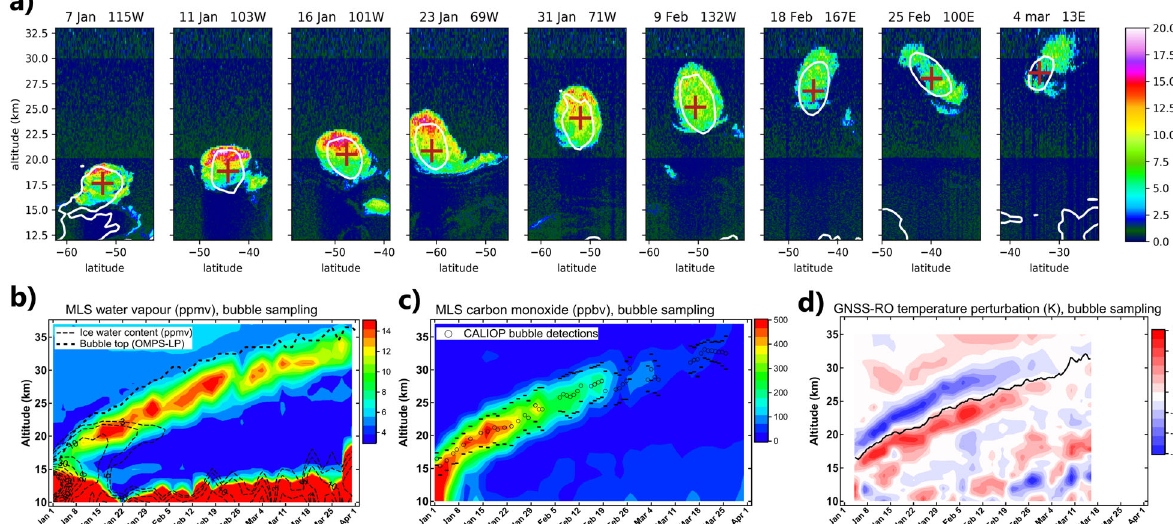
Fig. 5 Vertical evolution of the smoke bubble, its chemical composition and thermal structure. a Selection of CALIOP attenuated scattering ratio pro fi les for clear intersections of the bubble by the orbit except the fi rst panel of 1st of January that shows the dense and compact plume on its fi rst day in the stratosphere. The attenuated scattering ratio is calculated by dividing the attenuated backscattering coef fi cient by the calculated molecular backscattering. The data are further fi ltered horizontally by an 81-pixel moving median fi lter to remove the noise. The crosses show the projected interpolated location of the vortex vorticity centroid from the ECMWF operational analysis onto the orbit plane at the same time and the white contour shows the projected contour of the half maximum vorticity value in the pane passing by the vortex centroid and parallel to the orbit plane (see Fig. 6). b Evolution of the water vapour mixing ratio within the rising bubble based on MLS bubble detections (see “ Methods ” ). The dashed contours show the equivalent mixing ratio of ice water derived from MLS ice water content vertical pro fi les collocated with the bubble. The thick dashed curve marks the top altitude of the aerosol bubble determined as the level where OMPS-LP extinction triples that of the nearest upper altitude level. c Evolution of carbon monoxide (MLS) within the bubble. The centroid and the vertical boundaries of the aerosol bubble determined using CALIOP data are overplotted as circles and bars respectively. d Composited temperature perturbation within the smoke bubble from Metop GNSS radio occultation (RO) temperature pro fi les collocated with the smoke bubble (see “ Methods ” ). The black line shows the centroid of vortex detected from ECMWF data (see Supplementary notes 4.1 and Supplementary Fig.